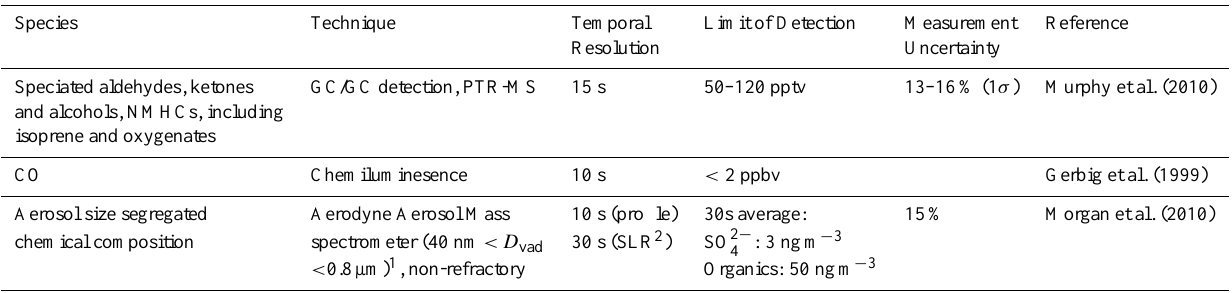
Table 1. Summary of ACE/OP3 measurements we use from the BAe 146 research aircraft. Species